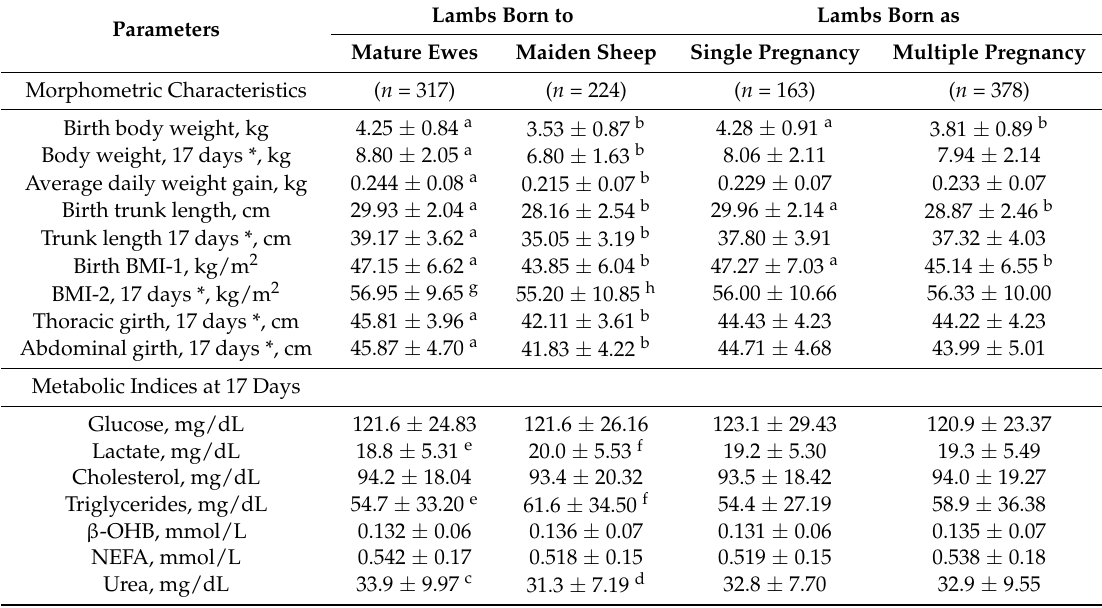
Table 4. Morphometric measurements and metabolic status of lambs, stratified by maternal age and pregnancy